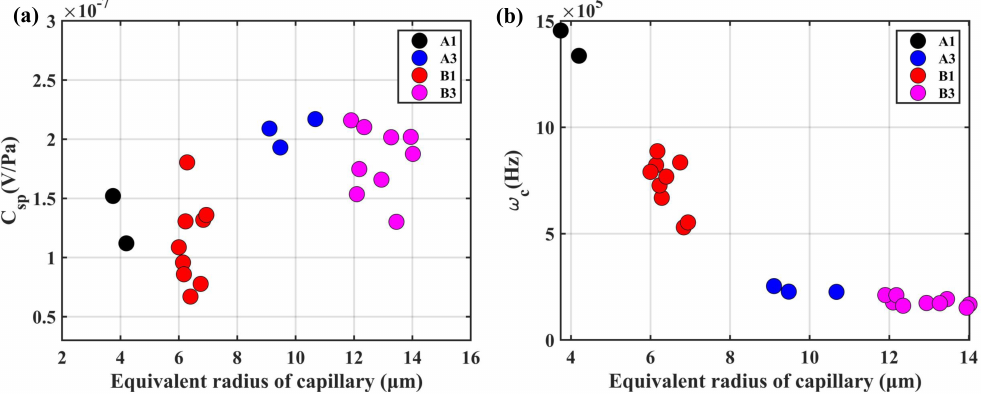
Figure 15. Frequency-dependence of SPC and permeability for different types of transducers at σ 0 = 115 mS: ( a ) the amplitude of C sp ; ( b ) the phase of C sp ; ( c ) the amplitude of permeability; ( d ) the phase of permeability.